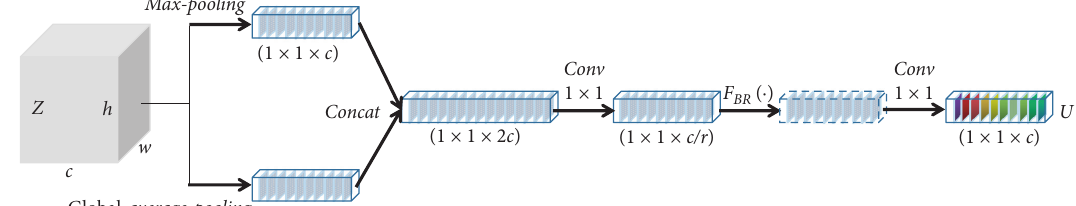
Figure 4: Proposed channel attention branch network.